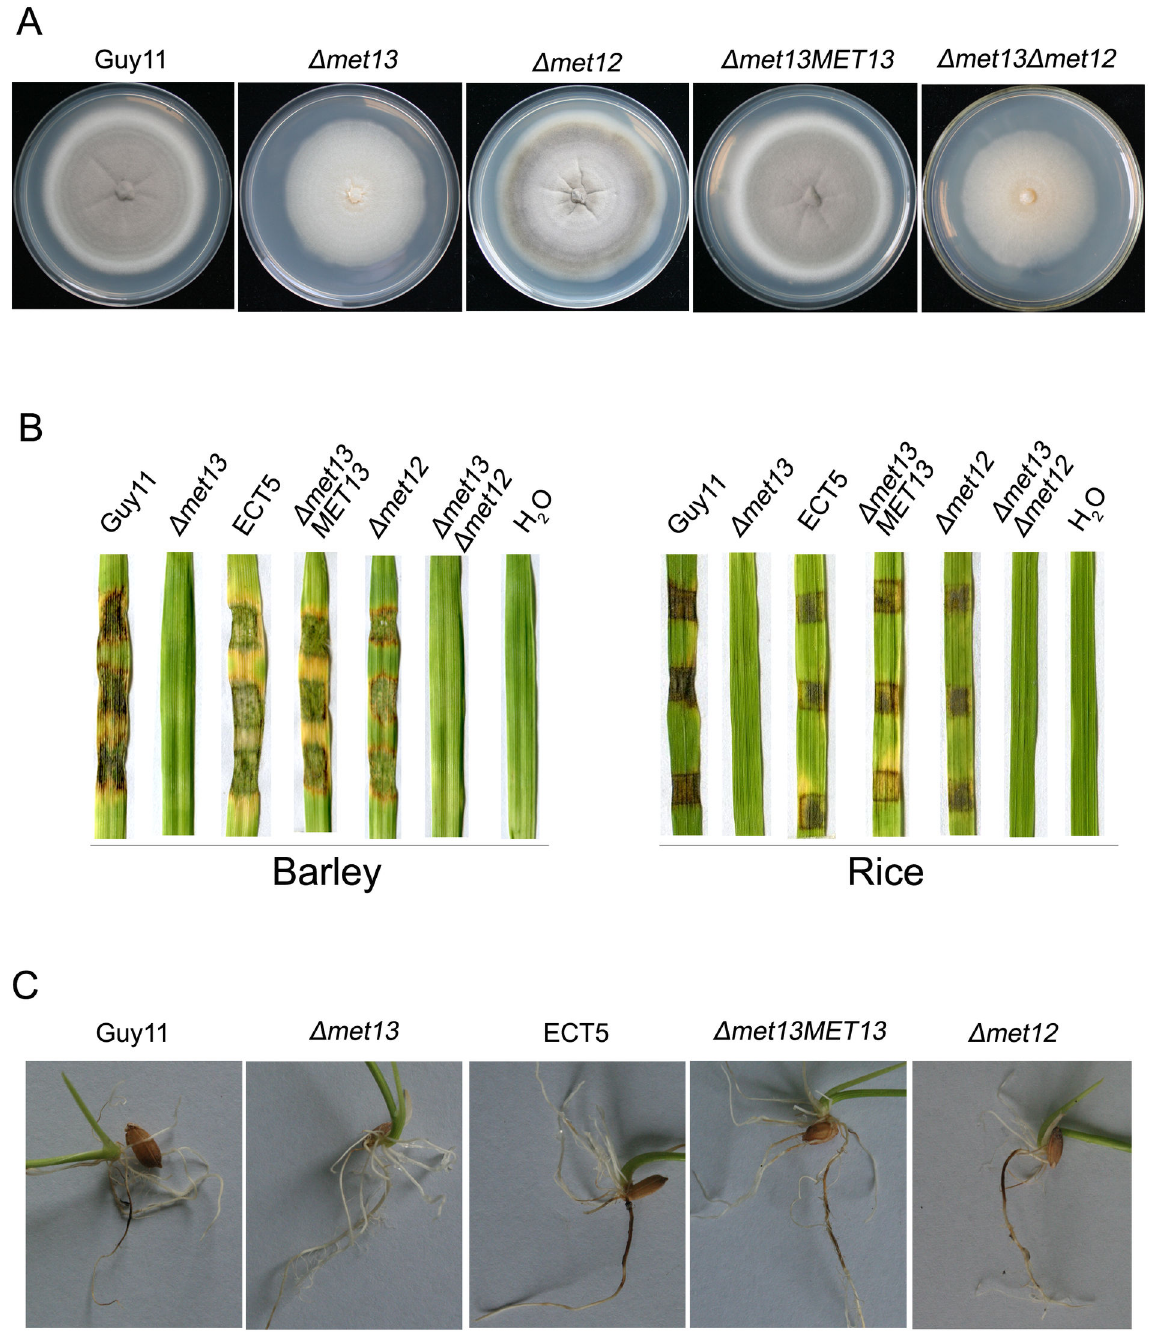
Figure 2. Colony growth and pathogenicity assays of Δmet12 , Δmet13 and Δmet13Δmet12 mutants. ( A ) Colonies of different strains. ( B ) Barley and rice segments inoculated with mycelium plugs from the wild-type strain Guy11, Δmet13 (K56), ectopic transformant (ECT5), Δmet13Met13 (C3), Δmet12 (K12-7) and Δmet13Δmet12 (DK7). H Rice root infection assays. Photographs were taken 5 days after inoculation.